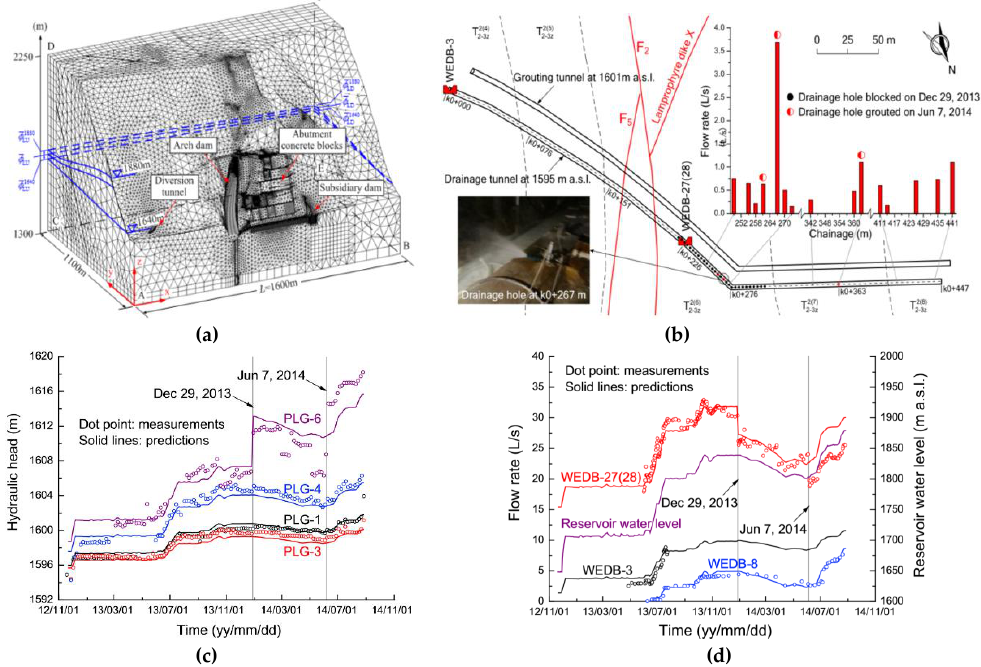
Figure 14. Inverse modelling and enforcement to water gushing from a drainage gallery at the left bank with altitude 1995 m in project Jinping [68]: ( a ) the inverse analysis numerical model; ( b ) the measured flow rates out of the drainage holes in the drainage tunnel at 1595 m above sea level on July 23, 2013, when the reservoir water level was about 1800 m above sea level; ( c ) comparison of the measured and calculated hydraulic heads at piezometers installed on the downstream side of grouting curtain; ( d ) comparison of the measured and calculated discharges through the measuring weirs.